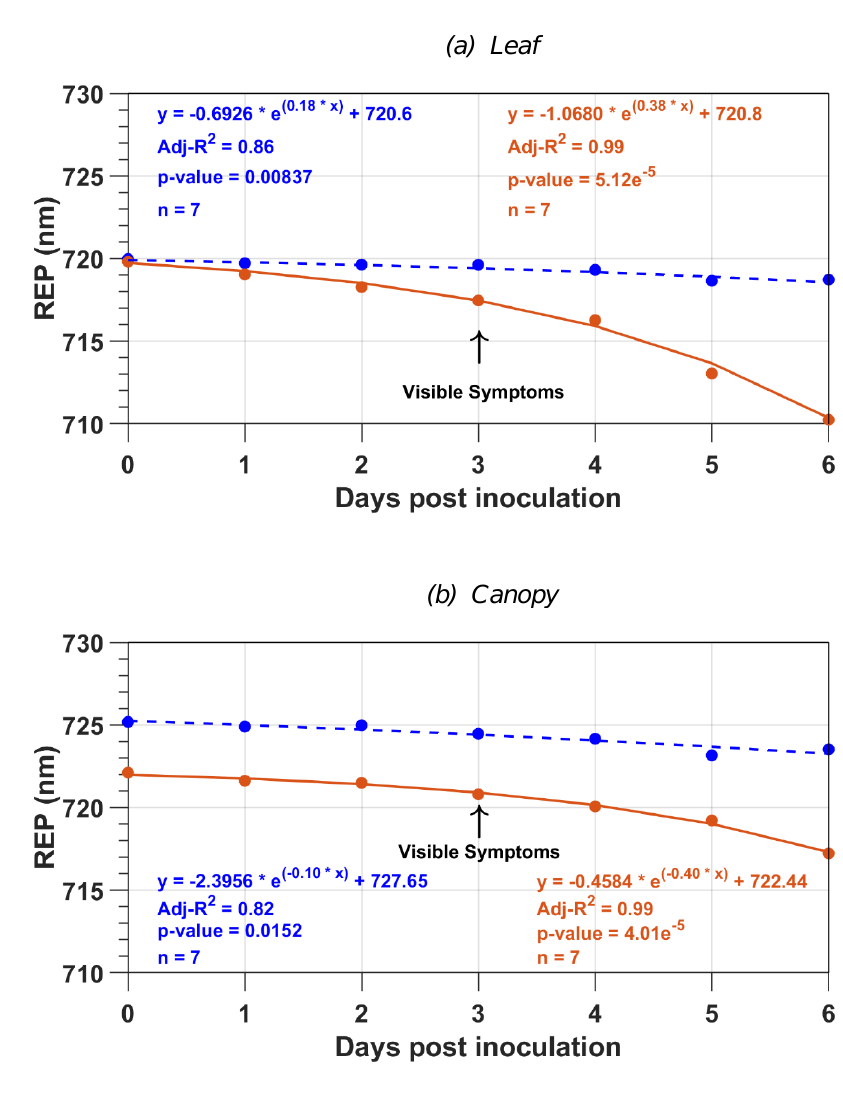
Figure 8. Exponential regression model fitted with the mean red-edge inflexion point (REP) wavelength (in nm) for (a) the leaf and (b) canopy level as a function of the number of days post-inoculation.